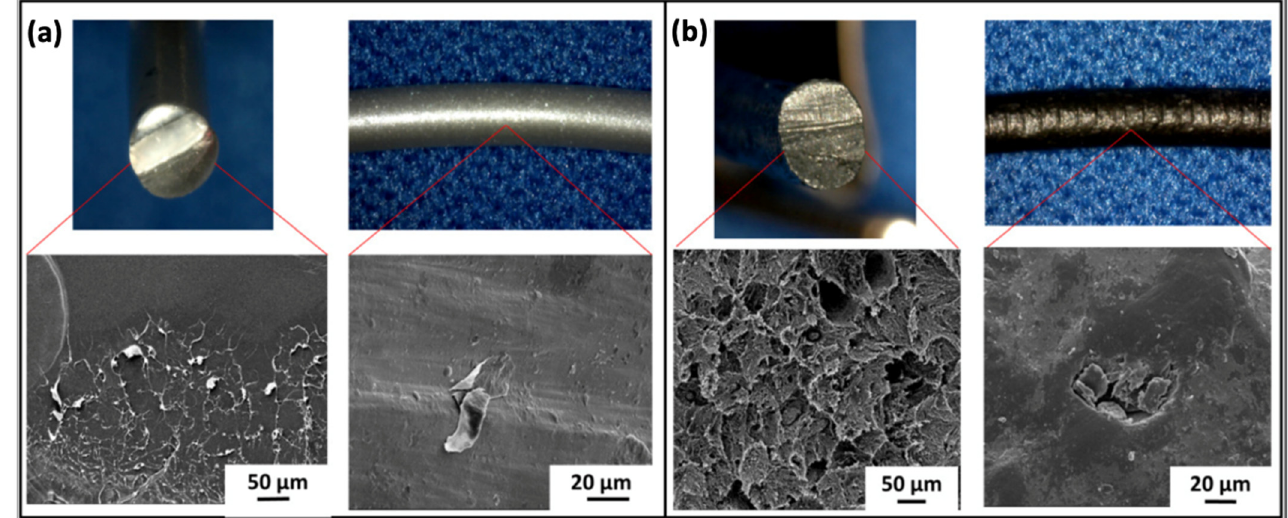
Figure 2. Top and cross-sectional microstructure of ( a ) neat PLA and ( b ) PLA-graphene filaments [57].